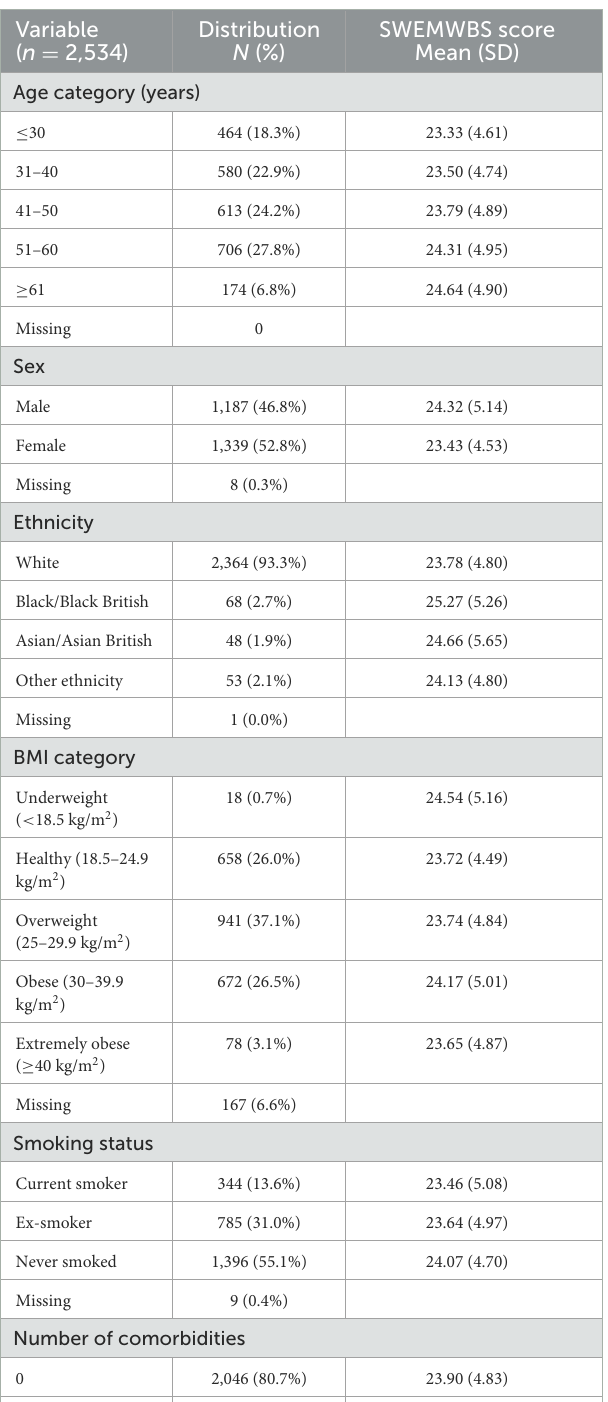
TABLE 2 Characteristics of sample and SWEMWBS